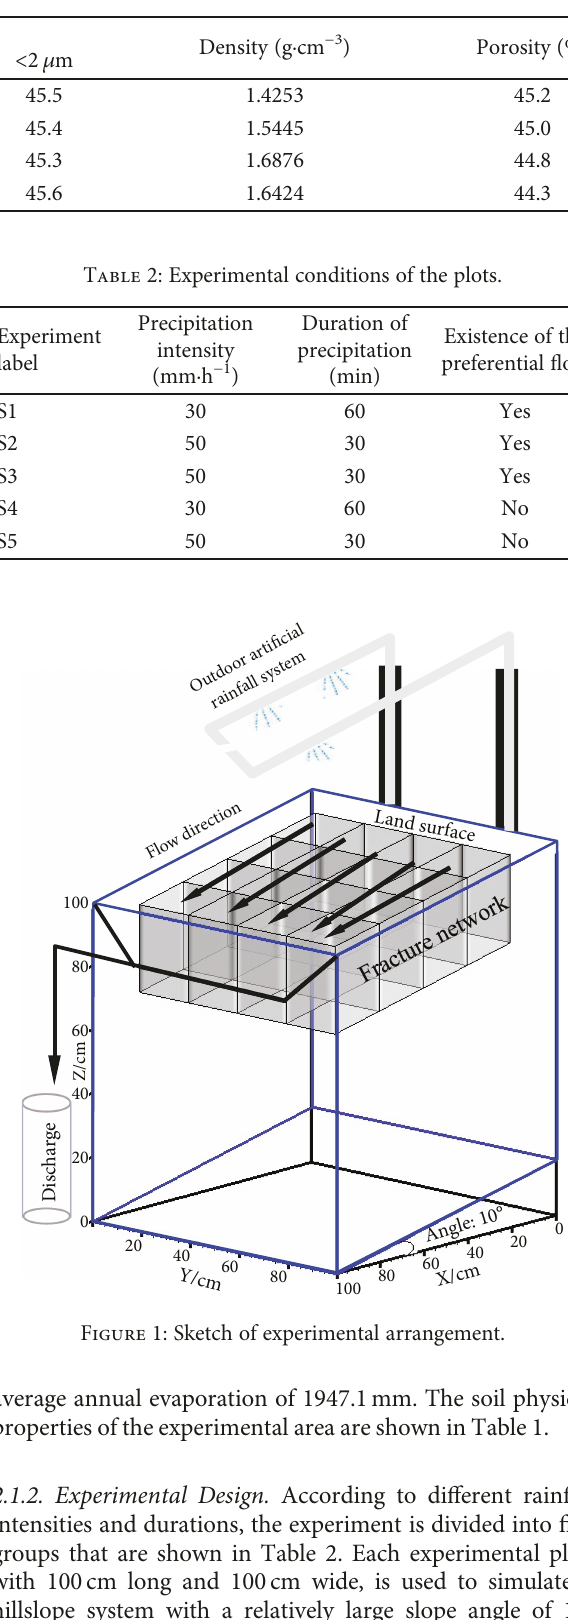
Table 1: Soil physical properties in experiment area.